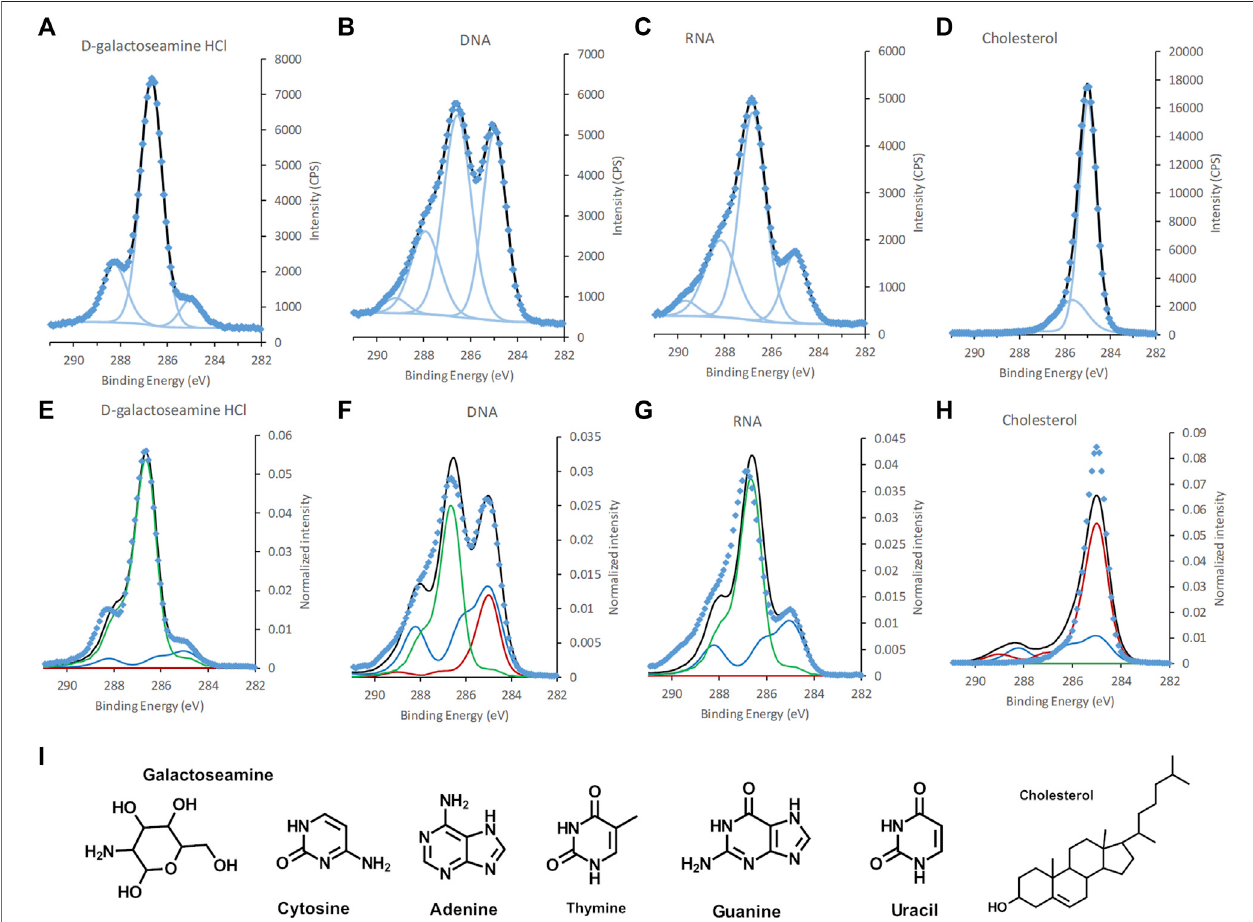
FIGURE3| C1sspectraof, (A,E) galactoseamine, (B,F) DNA, (C,G) RNA,and (D,H) cholesterol, (A – D) standardsamples fi ttedwithGL30peakshapesand (E – H) with spectral components. (I) Chemical structure of galactoseamine, nucleobases in DNA and RNA, and cholesterol. Data is represented by blue diamonds, the fi t by a solid black line, GL30 peak shapes are represented by light blue lines in fi gures (A – D) , and in (E – F) the blue line represents protein-like substance, green line polysaccharides and red line lipid-like substances.